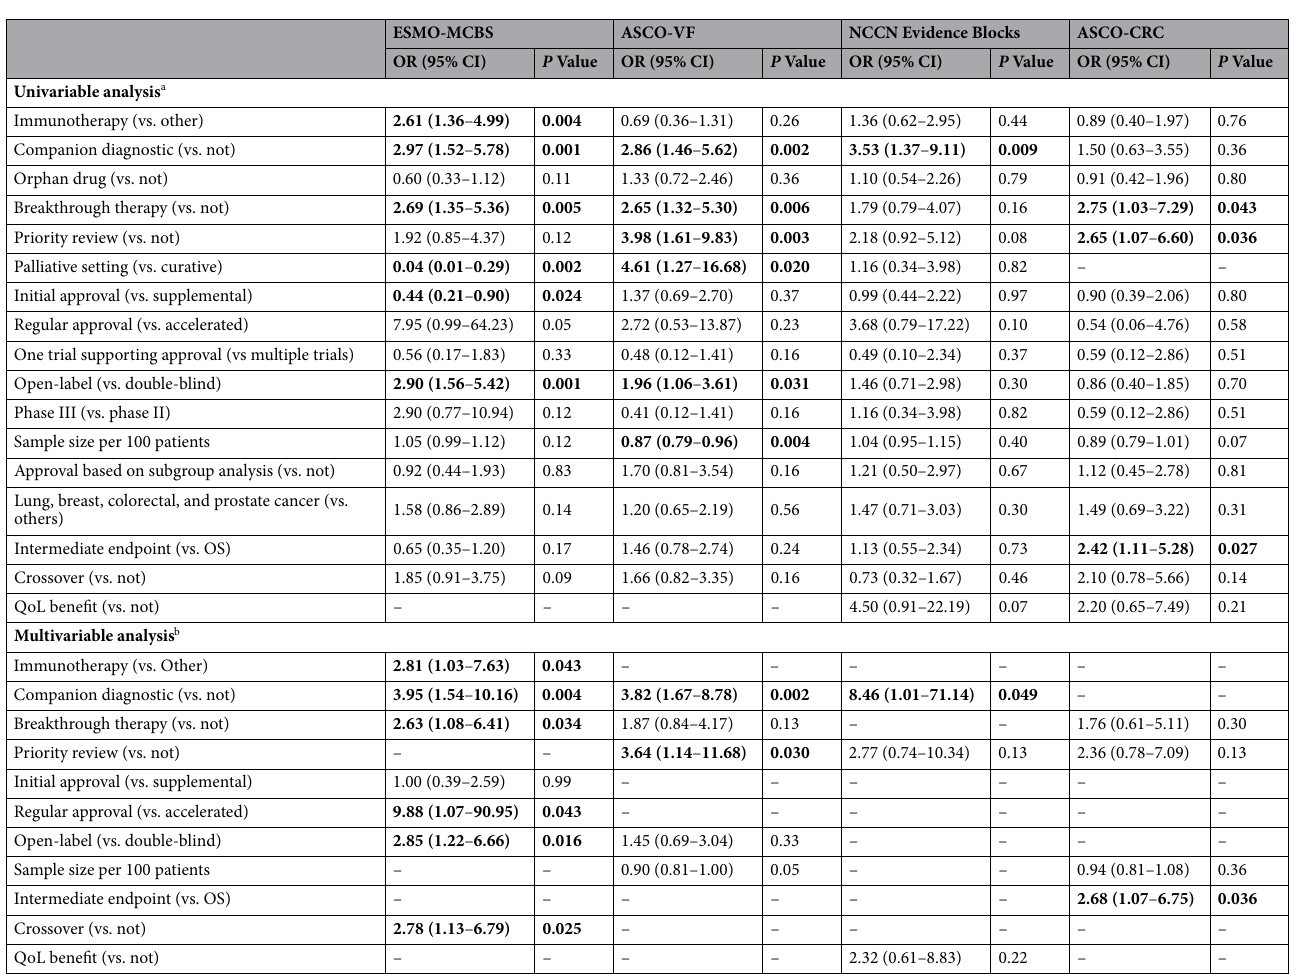
Table 4. Association between characteristics of applications and clinical trial and clinical benefit. Statistically significant values are in bold. ESMO-MCBS ESMO-Magnitude of Clinical Benefit Scale, ASCO-VF ASCO- Value Framework, NCCN National Comprehensive Cancer Network, ASCO-CRC ASCO-Cancer Research Committee, OR odds ratio, CI confidence interval, OS overall survival, QoL quality of life. a Based on univariable logistic regression. All P values are 2-sided. b Multivariable models were adjusted for variables with P values < 0.10 in the univariable